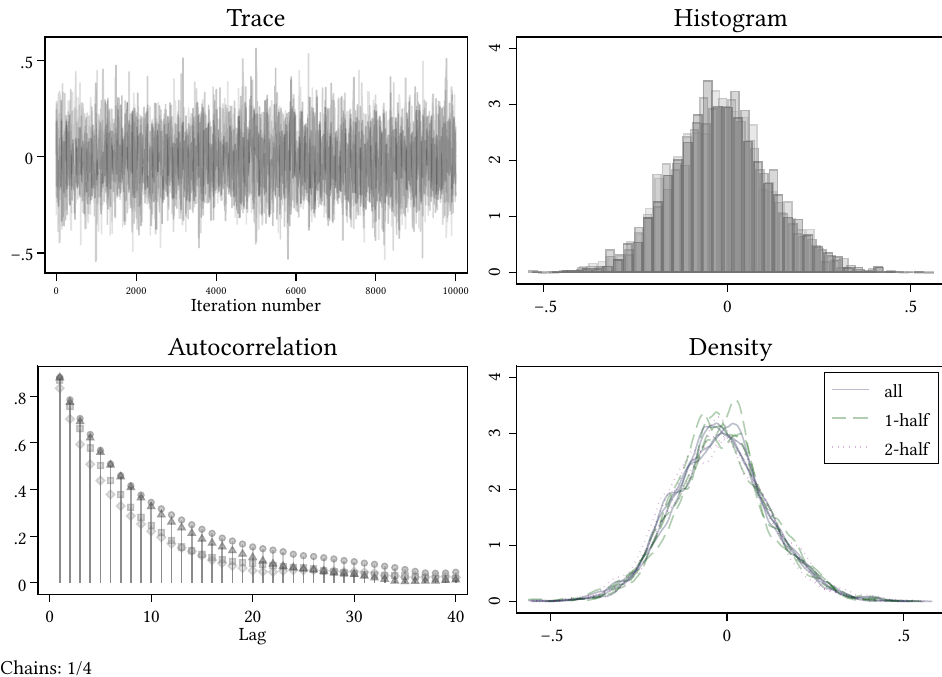
Figure A9. How awareness of the highest asks influences the response to the market price. The High Info